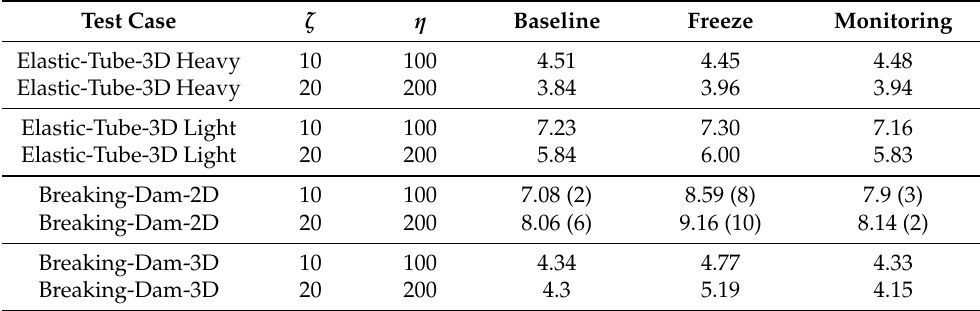
Table 1. Comparison of the average number of quasi-Newton iterations per time step for IQN- ILS with QR2 filter ( (cid:101) f = 0.01) for (i) pre-scaling update in every quasi-Newton iteration (column “baseline”), (ii) pre-scaling with freezing of weights after the first time step (column “freeze”), (iii) the new pre-scaling weight monitoring approach (column “monitoring”). For each test case, the first row uses a maximum of η = 100 iterations from previous ζ = 10 time steps, and the second row η = 200 and ζ = 20. Braces indicate how many time steps did not converge within 30 iterations before moving to the next time